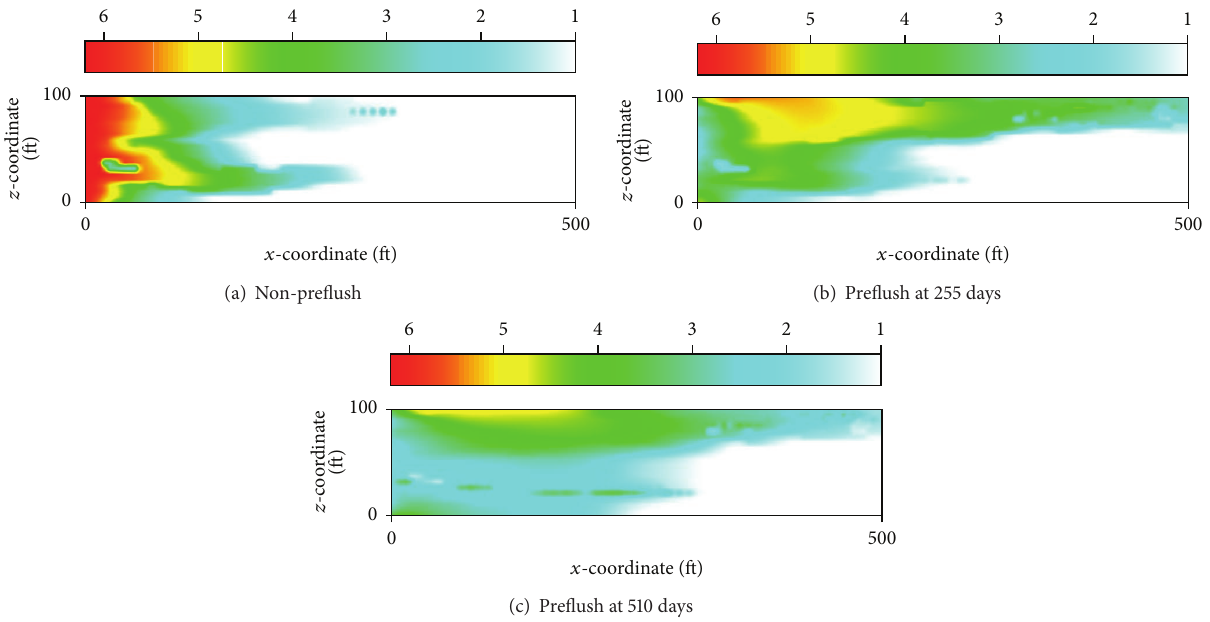
Figure 6: Permeability reduction factors depending on preflush at 1,000 days.